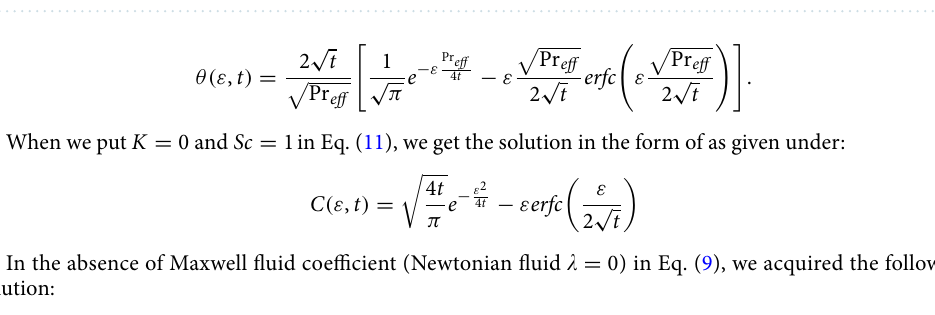
Figure 2. Concentration curves for various values of Sc and